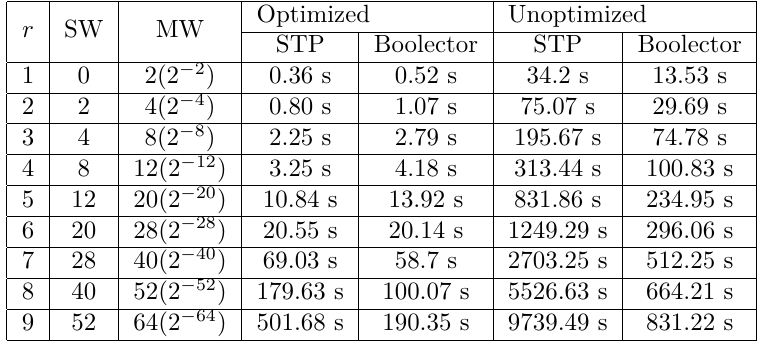
Table 8: The impact of the CRAFT ’s S-box optimization on the solvers’ run-time, where SW and MW respectively denote start-weight and minimum found weight through the search for the best single differential characteristic of r rounds of CRAFT in the single tweak